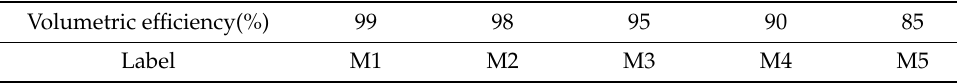
Table 6. Volume efficiency of hydraulic motor.